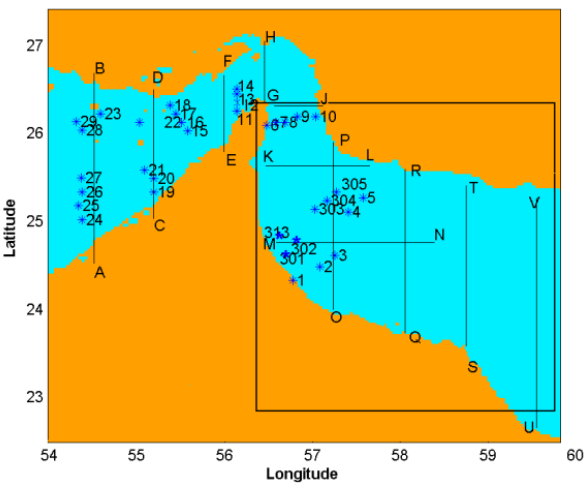
Fig. 5. Location of CTD stations during ROPME expedition (1992). The lines show the cross-sections where model results are extracted.